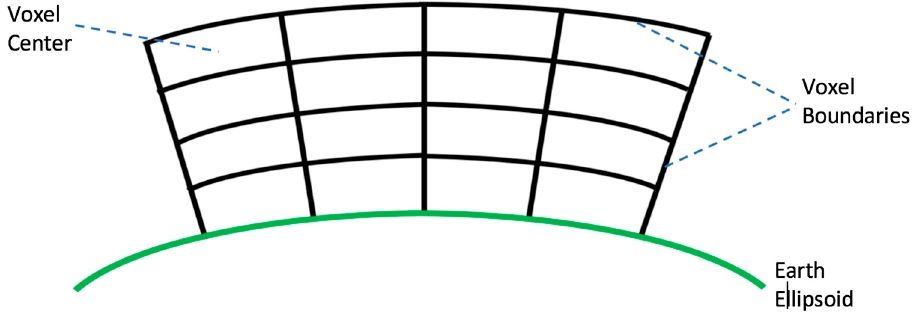
Figure 6. A diagram depicting a 2-D cross-section through the reconstruction domain. Voxels increase in volume as the altitude increases.